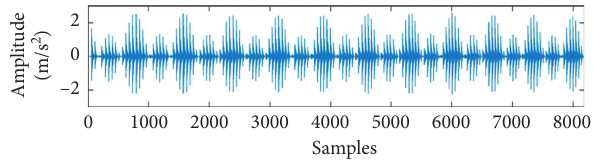
Figure 2: The inner race fault simulation